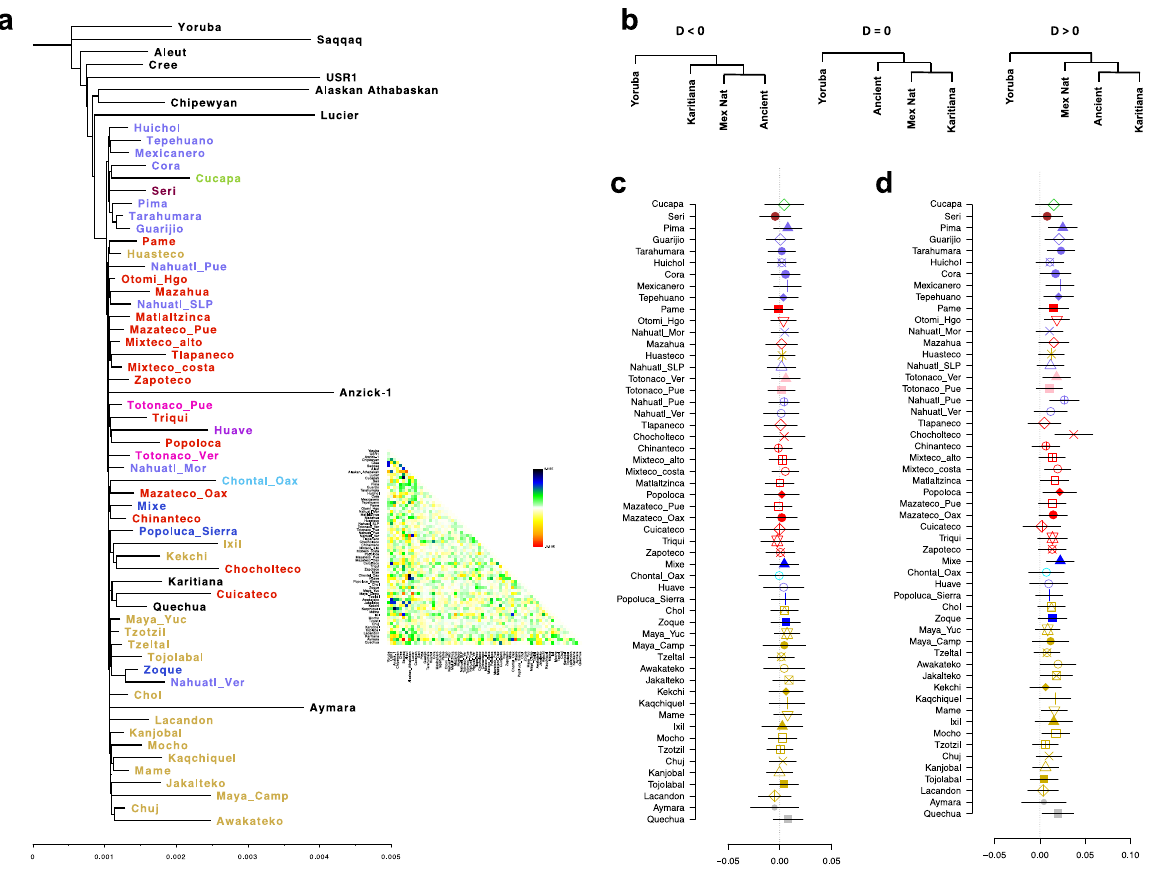
Fig. 5 Genetic relationship of Mexican Native populations with the ancient genomes of USR1 and Anzick-1. a Maximum-likelihood tree inferred from allele frequency, residual plot from the maximum-likelihood tree is shown. b Possible tree topologies resolved by D -statistics. c D -statistic in the form of D (Yoruba, USR1; Mex Nat, Karitiana) shows that all Mexican populations are related to the USR1 genome. d D -statistic in the form of D (Yoruba, Ancient; Mex Nat, Karitiana). Error bars in c , d represent 3 standard errors estimated by a weighted block jackknife. Mex Nat Mexican Native